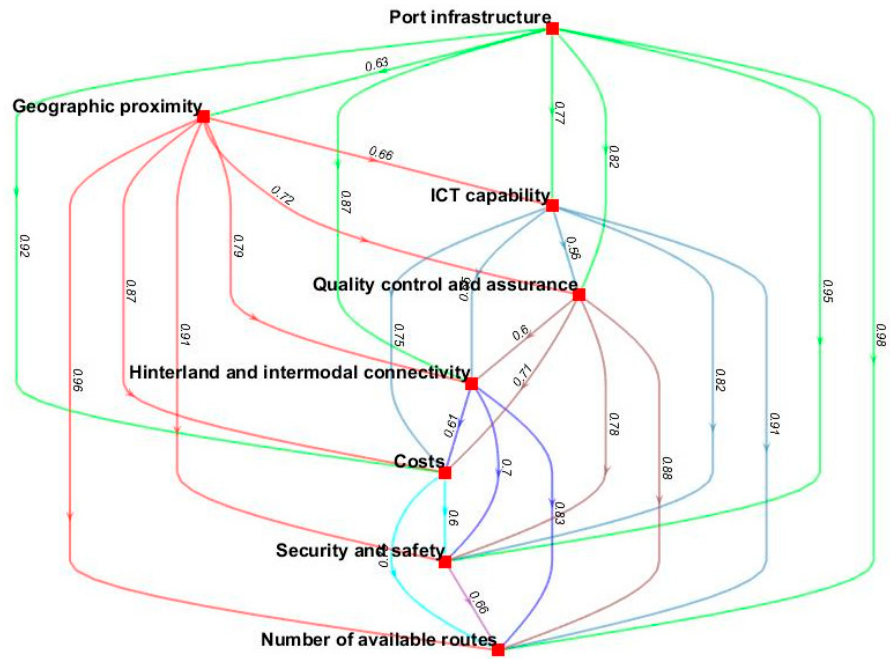
Figure 7. Graphical illustration of the credal ranking of the eight criteria in the carrier selection problem. Table 4. Aggregated result summary of the carrier selection problem.